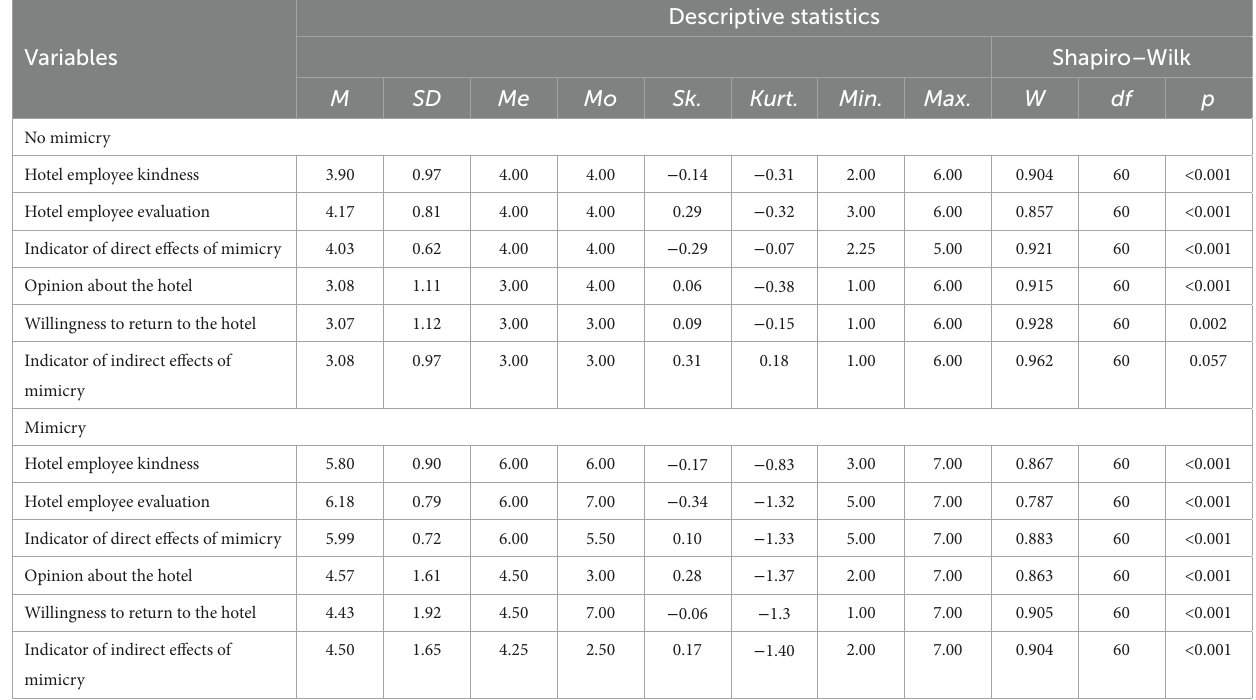
TABLE 3 Descriptive statistics of all study variables within the no mimicry and mimicry group (Main Experiment).